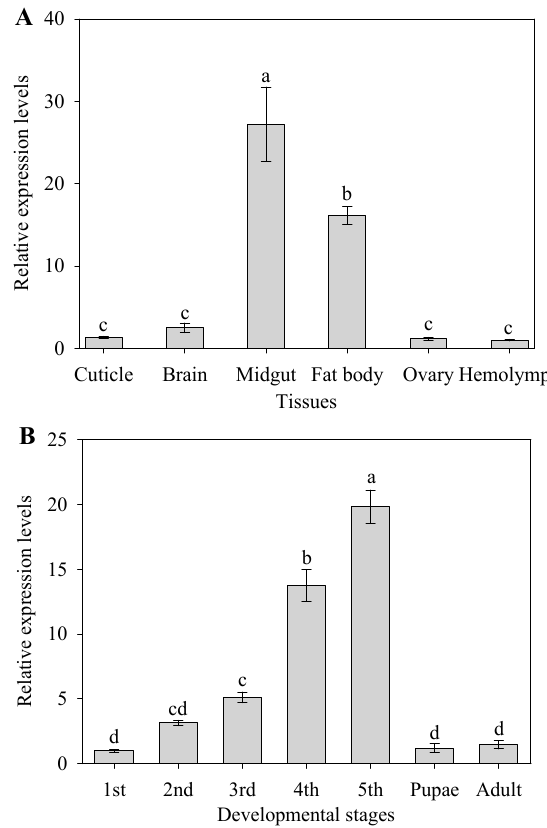
Figure 2. Expression of CYP9A105 in different tissues ( A ) and different developmental stages ( B ) of Spodoptera exigua . Real-time RT-qPCR analysis was used to determine the relative transcript levels for each gene. Data shown represent means ± SE derived from three biological replicates. Different letters above bars indicate significant differences ( p < 0.05) according to the Duncan’s multiple range test.